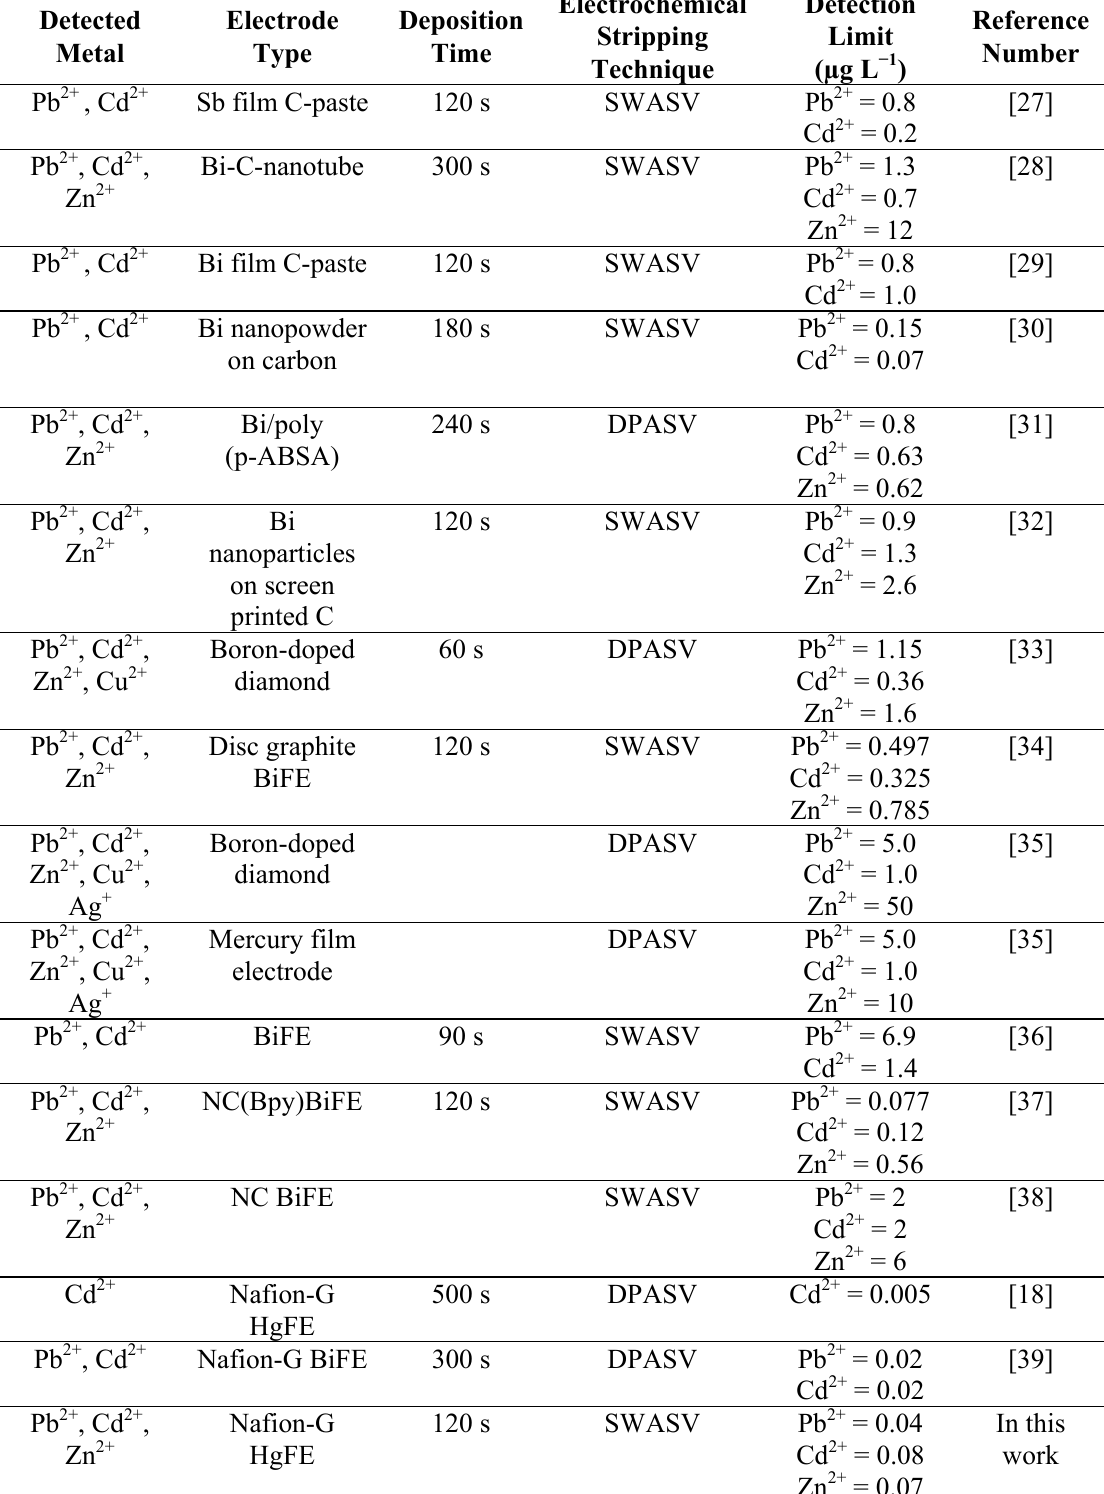
Table 3. Summary of work done previously on Zn 2+ , Cd 2+ and Pb 2+ on various